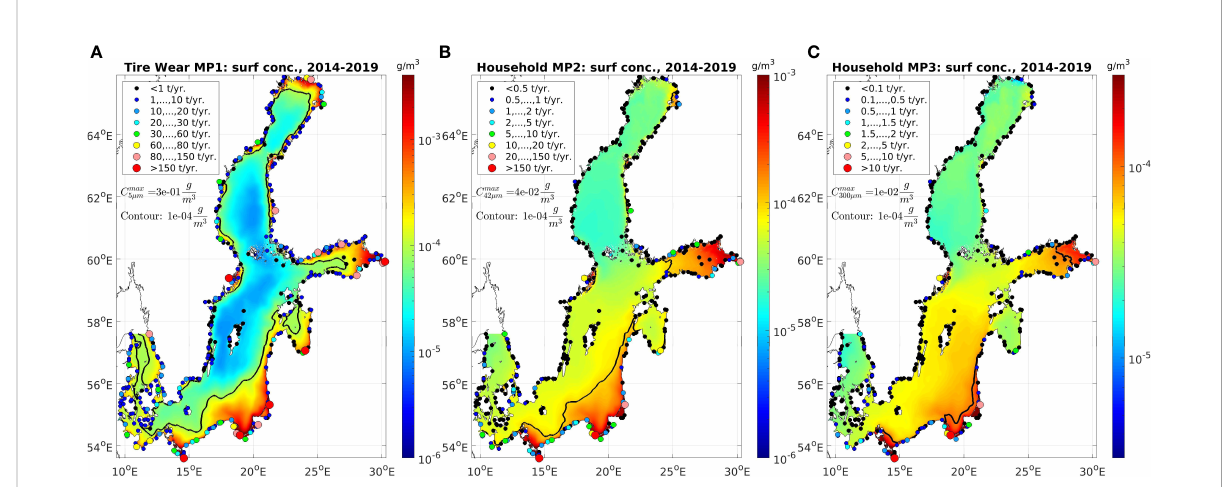
FIGURE 6 Surface pattern of microplastics from tire wear microplastics MP1 (A) and households microplastics MP2 (B) and MP3 (C) , 6-year mean 2014 – 2019. Contours show the average concentrations of 10 -4 g/m 3 .